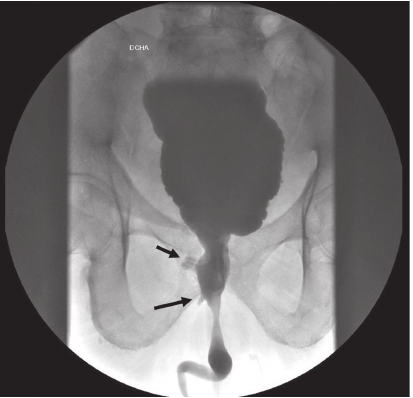
Figure 1 - voiding cystourethrography revealed small contained urethral leaks (black arrows).